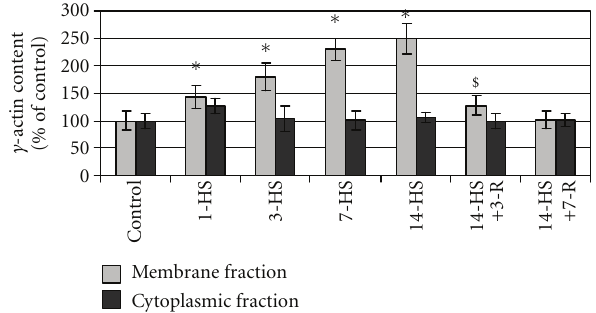
Figure 3: Gamma-actin content in the rat’s left ventricular myocytes under gravitational unloading and subsequent reloading; n = 7 samples for each group; ∗ P < 0 . 05 as compared to the group “Control”, $ P < 0 . 05 as compared to the group “14-HS”.